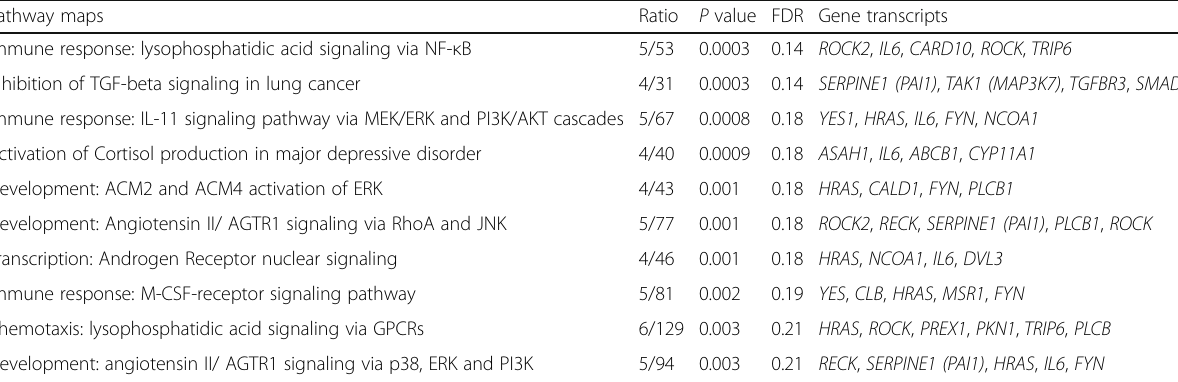
Table 4 Top 10 enriched pathways in responders compared to non-responders after 7 weeks of omega-3 supplementation Pathway